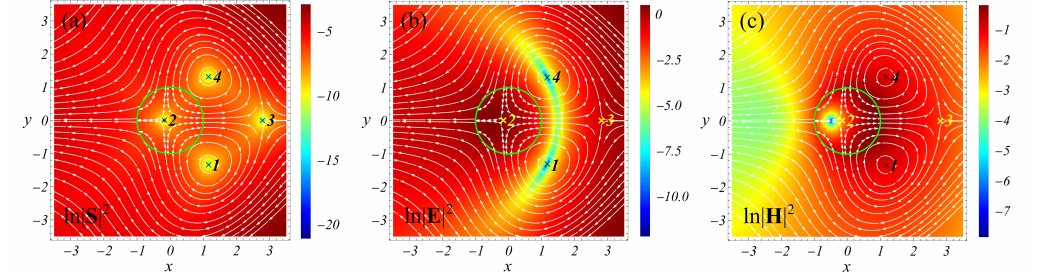
Figure 3. Light scattering by a cylinder in a vacuum. Streamlines for the Poynting vector field and the logarithm of the square of the modulus of the Poynting vector ( a ), electric ( b ), and magnetic ( c ) fields in the xy -plane. The TE polarization (vector E of the incident wave lies in the plane of the figure). q = 0.1, ε = − 1. The pattern is symmetric with respect to the line y = 0. A green circle designates the surface of the cylinder. Crosses marked with numbers are the positions of singular points. Points 1,2,7,8 are centers; the rest are saddles. | S | 2 = 0 at all singular points. The centers and saddles are the H-field-induced and polarization-induced singularities, respectively. See text for details.